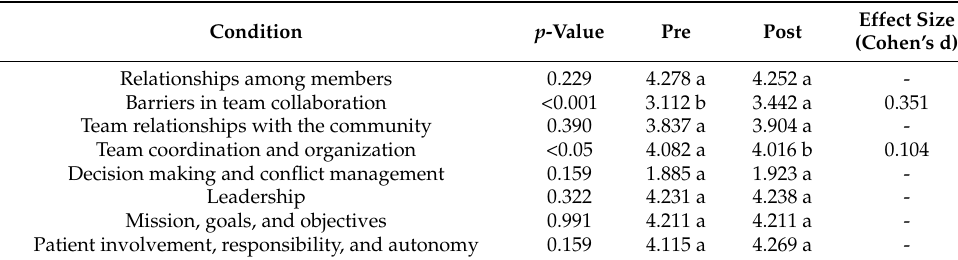
Table 5. Overall perception of interprofessional collaboration practices before and after clinical pathway intervention (N HUH =